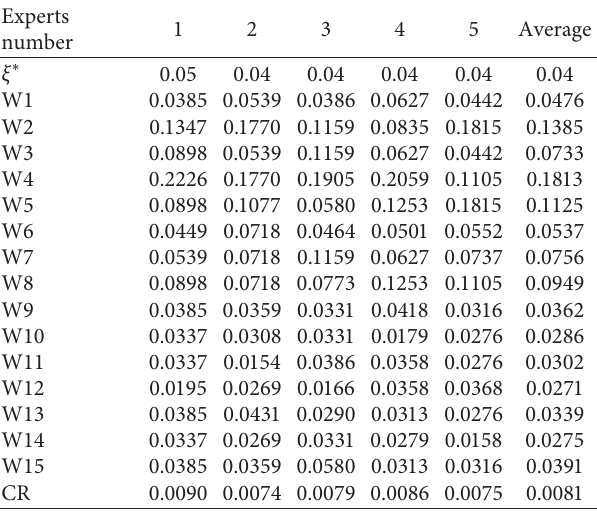
Table 5: Indicator weight and consistency coefficient. Experts